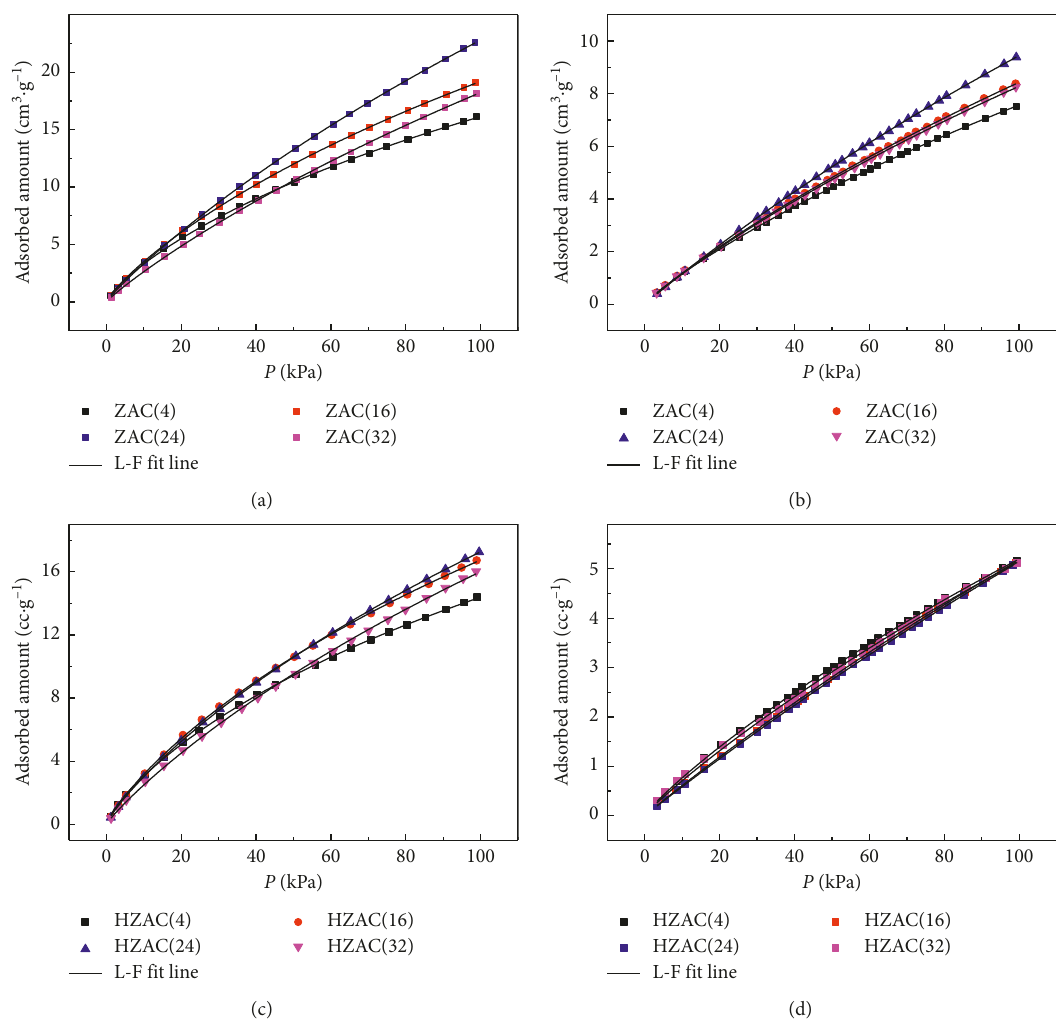
Figure 5: Adsorption isotherm of (a, c) CH 4 and (b, d) N 2 at 273K on ZAC( t a ) and HZAC( t a ).